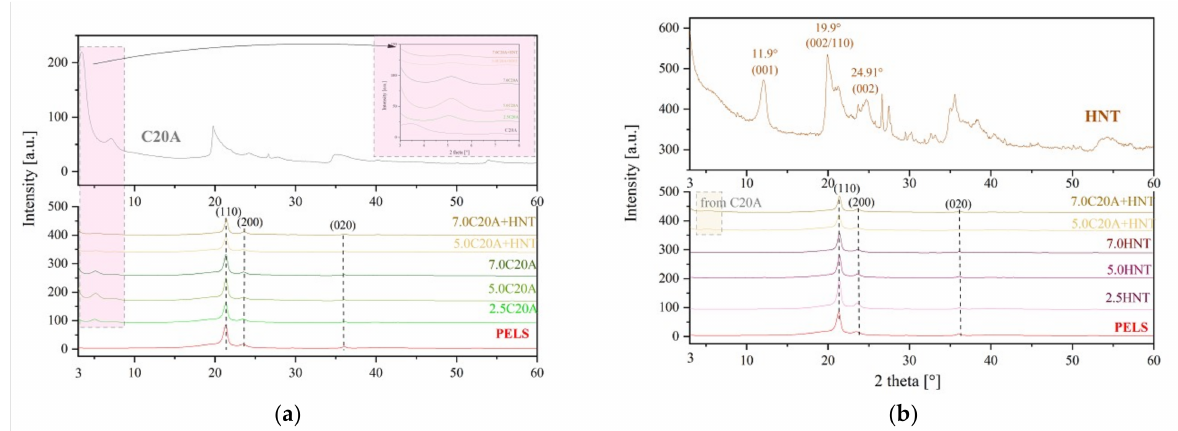
Figure 7. XRD patterns for the series of nanocomposites based on PELS: ( a ) in reference to C20A; ( b ) in reference to